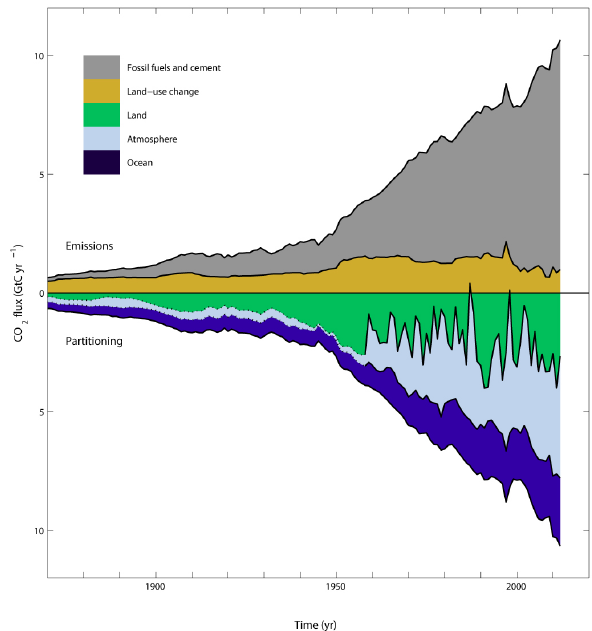
Figure 2. Combined components of the global carbon budget illus- trated in Fig. 1 as a function of time, for (top) emissions from fossil- fuel combustion and cement production ( E FF ; grey) and emissions from land-use change ( E LUC ; brown), and (bottom) their parti- tioning among the atmosphere ( G ATM ; light blue), land ( S LAND ; green) and oceans ( S OCEAN ; dark blue). All time series are in GtCyr − 1 . G ATM and S OCEAN (and by construction also S LAND ) prior to 1959 are based on different methods and shown as a dashed line. The primary data sources are for fossil-fuel and cement emis- sions from Boden et al. (2013), with uncertainty of about ± 5% ( ± 1 σ) ; land-use change emissions from Houghton et al. (2012) with uncertainties of about ± 30%; atmospheric growth rate prior to 1959 is from Joos and Spahni (2008) with uncertainties of about ± 1–1.5GtCdecade − 1 or ± 0.1–0.15GtCyr − 1 (Bruno and Joos, 1997), and from Dlugokencky and Tans (2013) from 1959 with un- certainties of about ± 0.2GtCyr − 1 ; ocean sink prior to 1959 is from Khatiwala et al. (2013) with uncertainty of about ± 30%, and from this study from 1959 with uncertainties of about ± 0.5GtCyr − 1 ; residual land sink is obtained by difference (Eq. 8), resulting in un- certainties of about ± 50% prior to 1959 and ± 0.8GtCyr − 1 after that. See the text for more details of each component and their un-